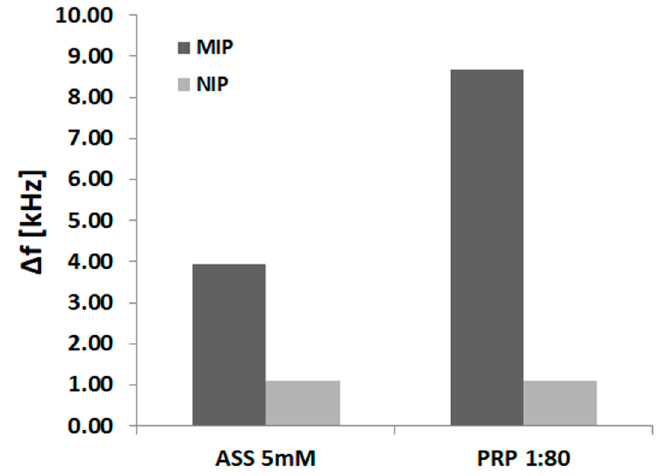
Figure 4. Influence of acetyl salicylic acid on thrombocyte MIP sensor